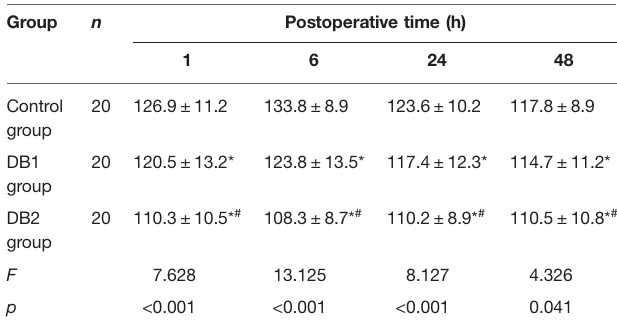
TABLE 2 | Comparison of systolic blood pressure of puerperae at different times after surgery among three groups (mean±SD, mmHg).